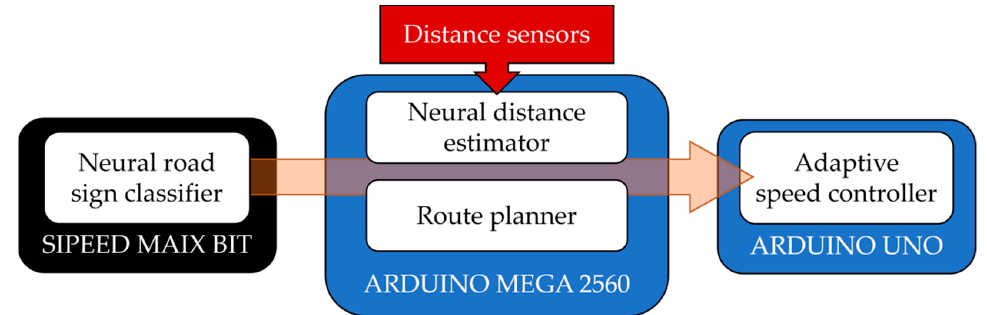
Figure 2. The scheme of a microcontroller system of the analyzed